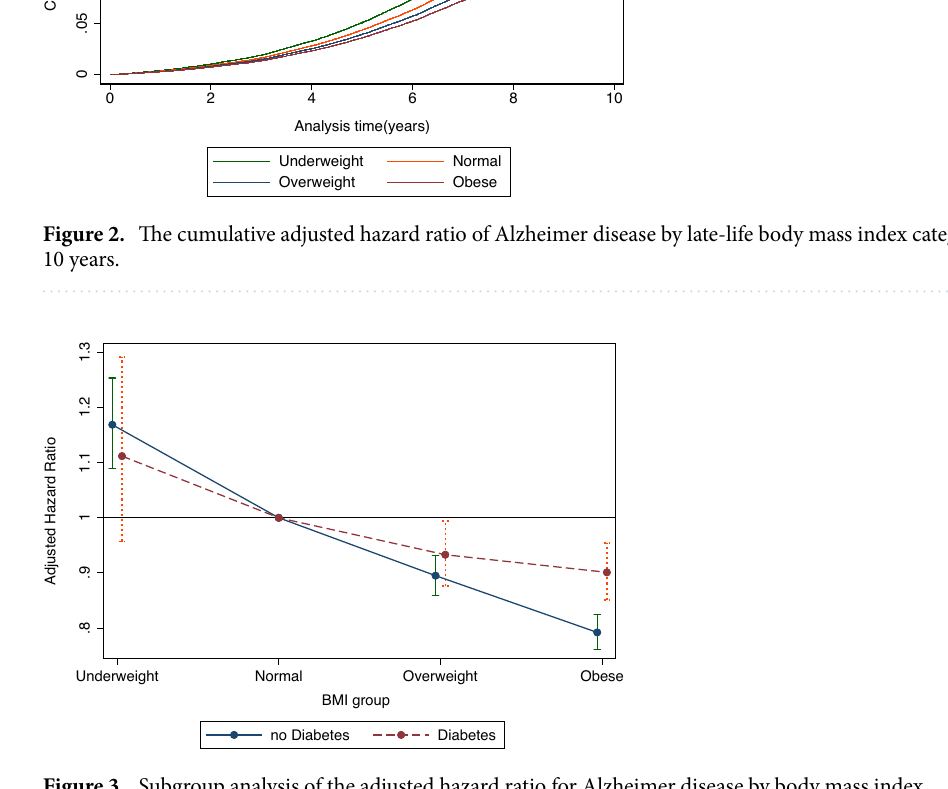
Figure 3. Subgroup analysis of the adjusted hazard ratio for Alzheimer disease by body mass